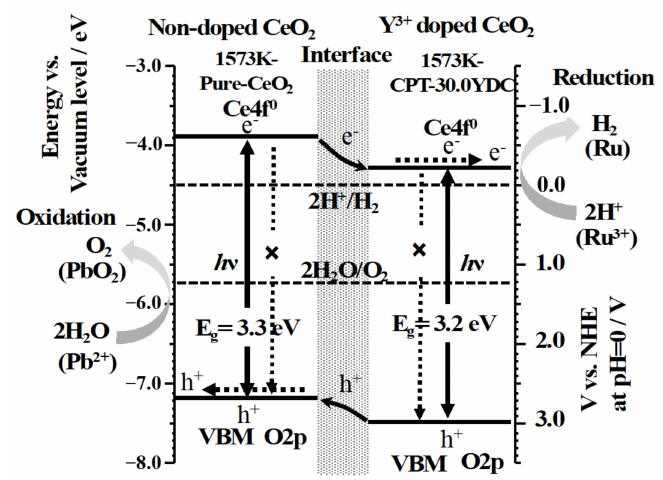
Figure 8. A schematic model of charge separation and efficient overall water splitting at the interface between 1573K-Pure-CeO 2 and